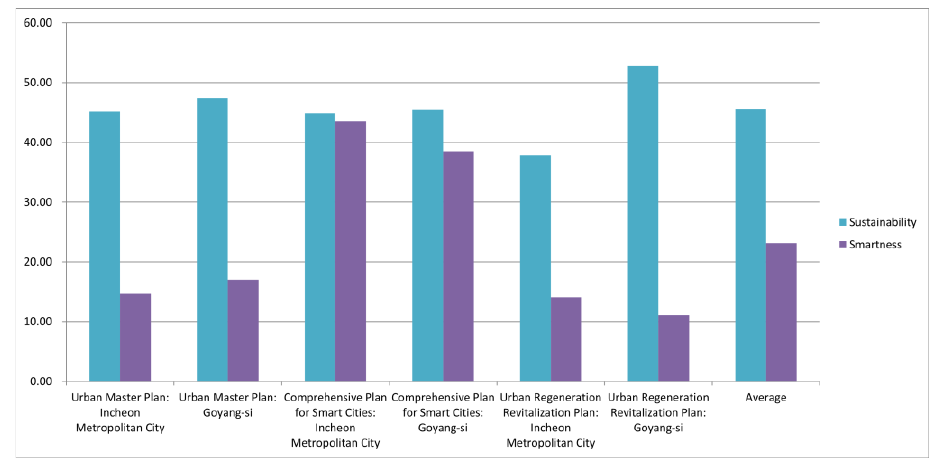
Figure 6. Overall score for sustainability and smartness by plan.